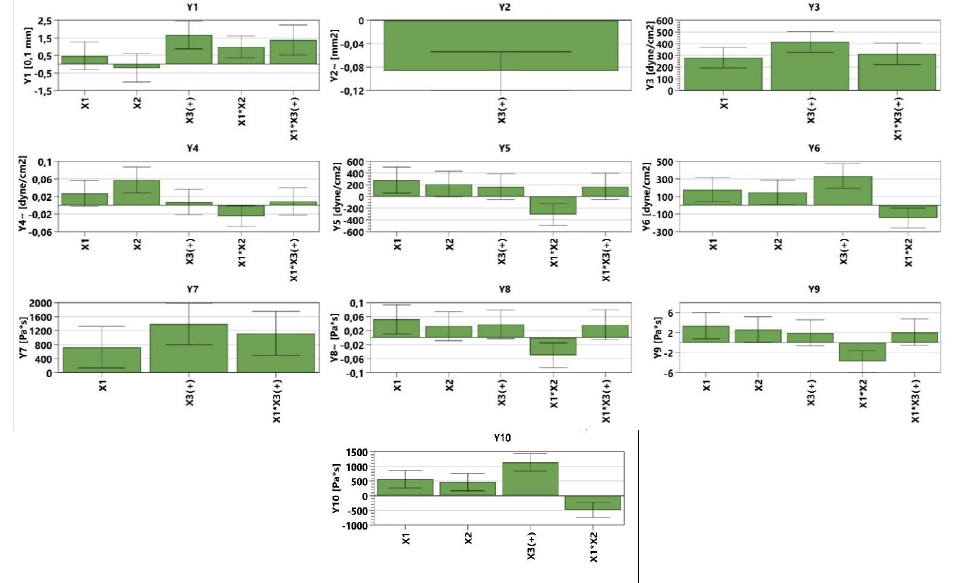
Figure 3. The influence of the independent variables on the dependent variables.